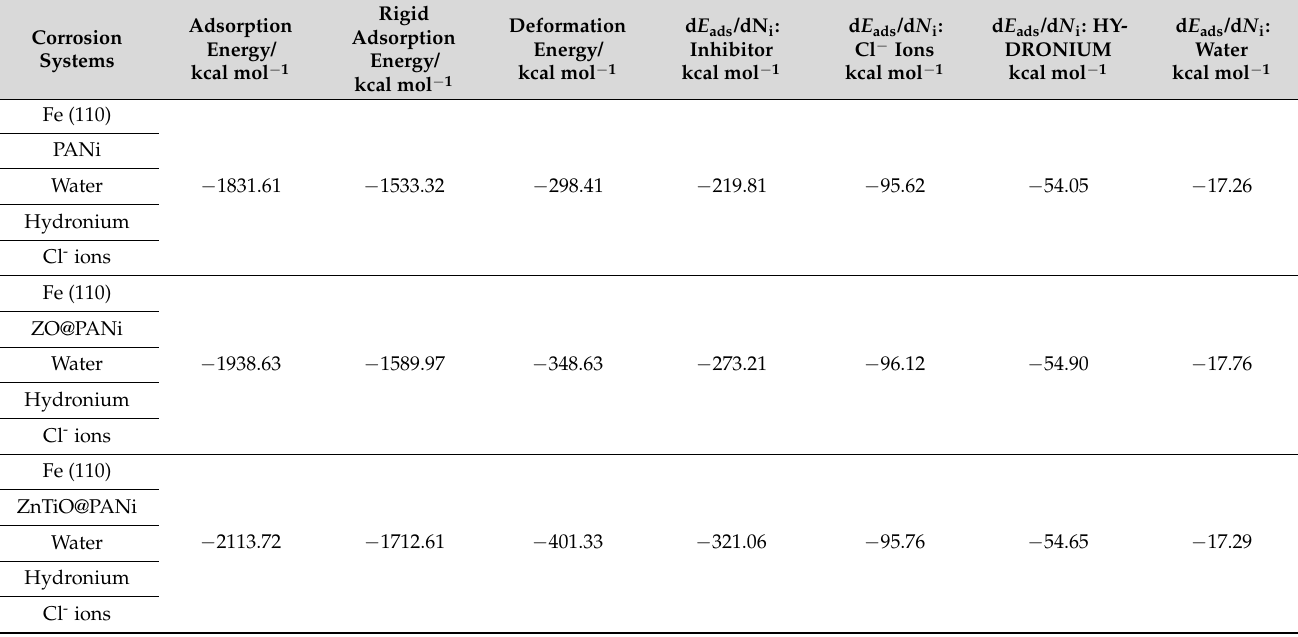
Figure 12. The highest suitable adsorption configuration based on the adsorption locator module for the ZnTiO@PANi compounds on iron (1 1 0) substrate. Table 5. Information and parameters derived from MC simulations of the PANi, ZO@PANi, and ZnTiO@PANi compounds adherent to iron (1 1